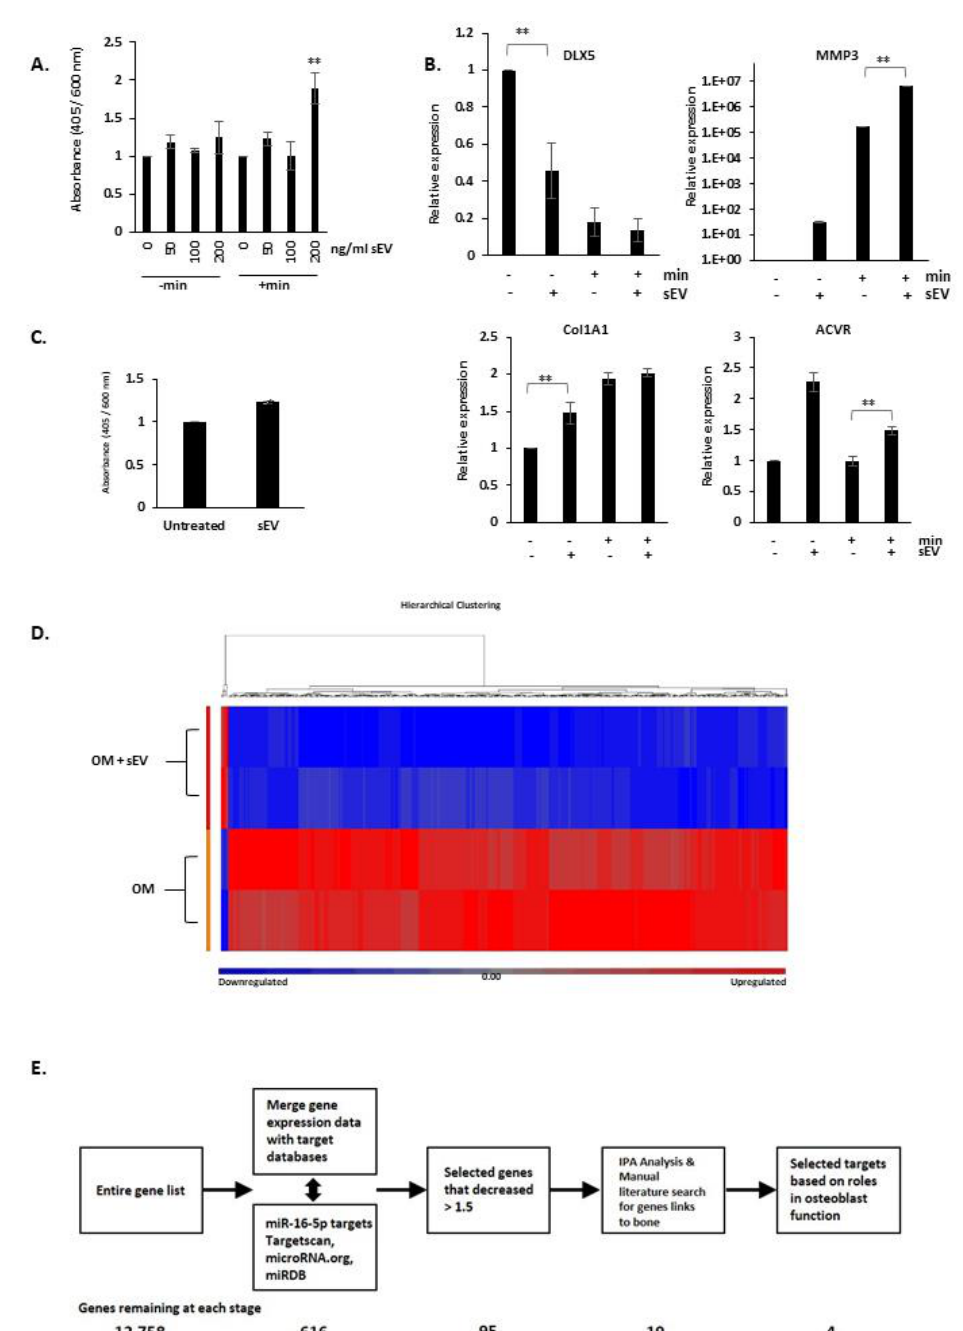
Figure 5. EVs from PC3 cells induce mineralisation of 7F2 osteoblasts. Mineralisation of sEV treated 7F2 cells. ( A ), Min- eralisation of 7F2 cells treated with 0–200 ug/mL sEVs for 10 days with (+min) or without osteogenic media (-min). Graph shows alizarin red absorbance (405 nm) normalised to a post stain crystal violet stain (600 nm) for cell number. ( B ), Q-PCR analysis of osteoblast differentiation genes in 7F2 cells treated with sEVs (+) or with PBS vehicle (-) in regular (-) or with osteogenic media (+). Data is normalised to housekeeping genes β -actin, GAPDH and RPL19. ( C ), Mineralisation of 7F2 cells treated with 200 ug/mL sEVs for 10 days (or PBS control) in the presence of β -glycerophosphate. Graph shows alizarin red absorbance (405 nm) normalised to a post stain crystal violet stain (600 nm) for cell number. ( D ), Hierarchical clusteringdata from RNA-seq of 7F2 cells treated with sEVs. Data shows genes significantly changed in 7F2 by sEV treatment. Data represents two independent experiments. ( E ), Flow chart schematic of the data analysis pathway and miR target prediction, followed by Ingenuity pathway analysis and manual searches for osteoblast activity. ** p =